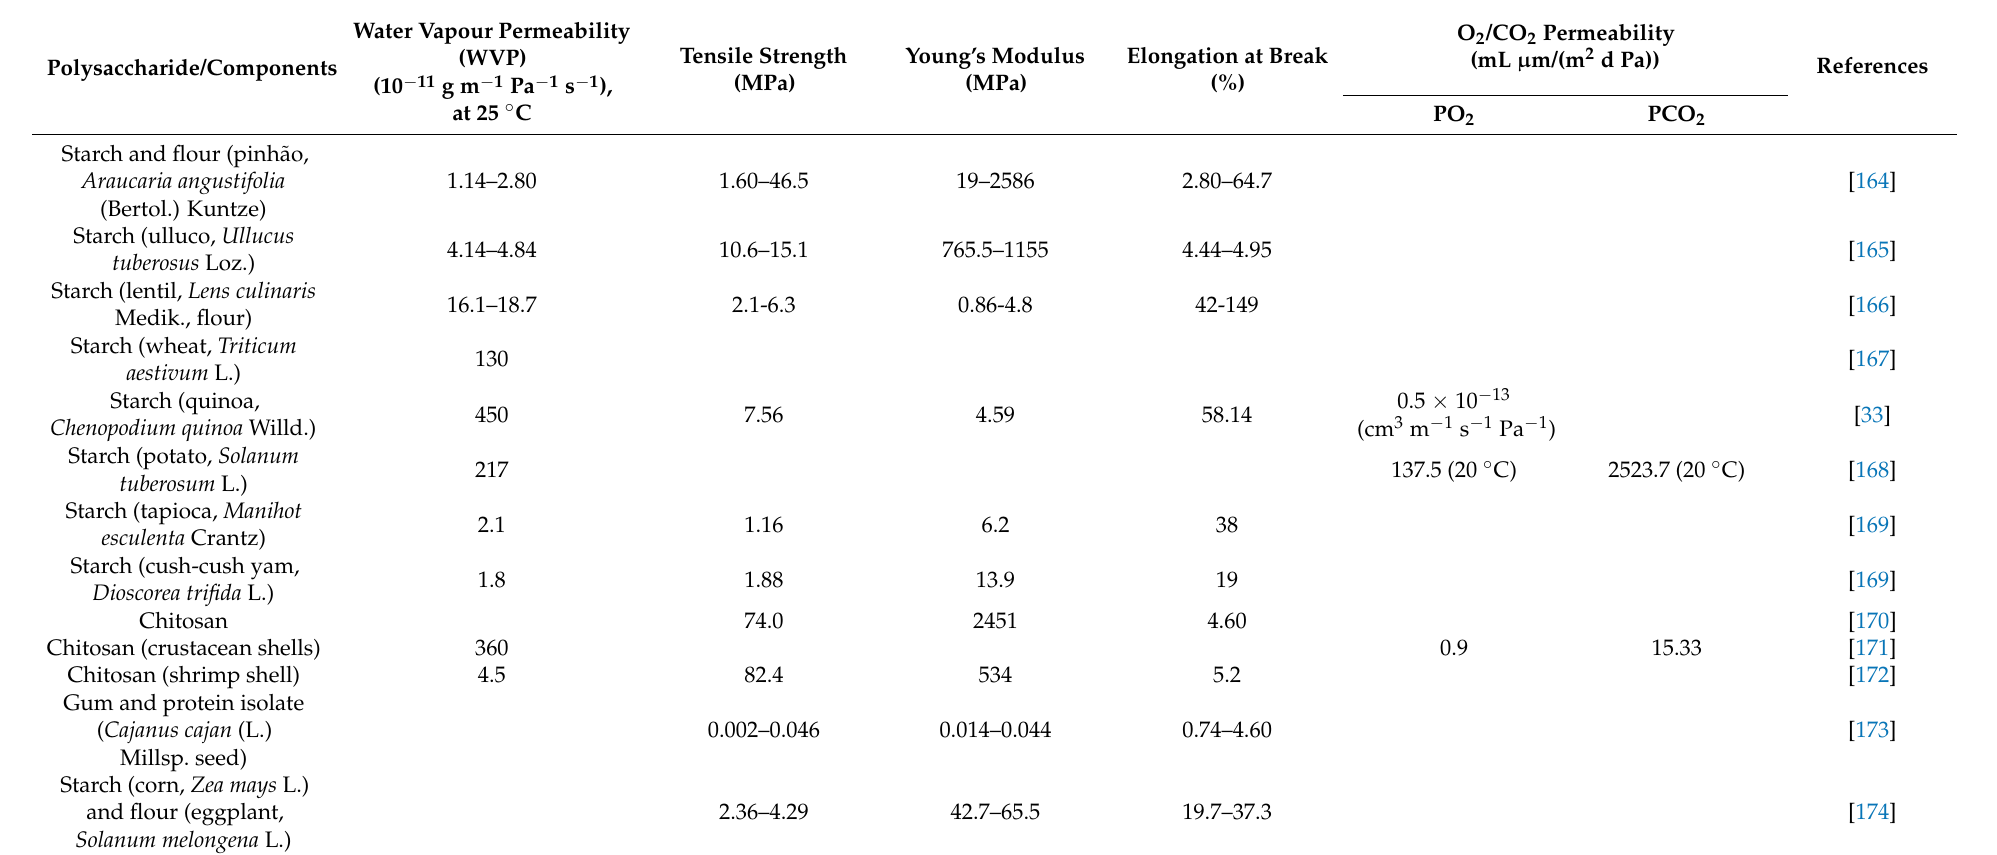
Table 4. Physical and mechanical properties of edible films and